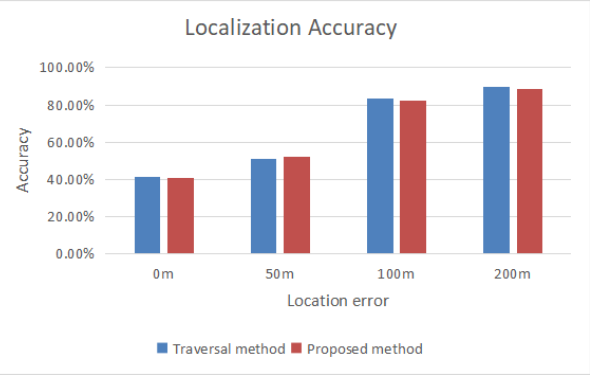
Figure 39. The localization accuracy of the proposed method is similar to that of the traversal